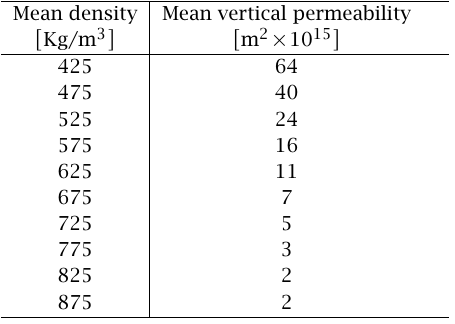
Table 4.1 . Vertical permeability density correction